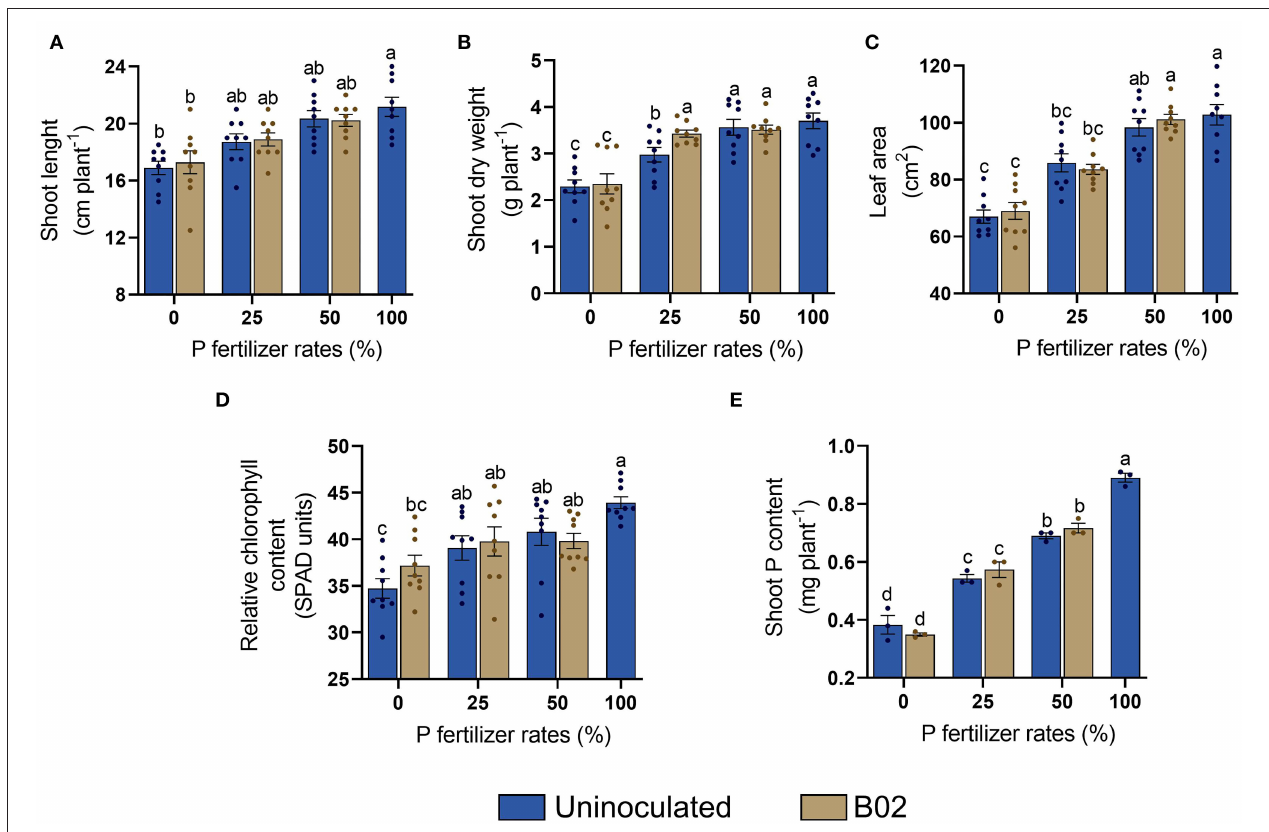
FIGURE 5 | Influence of the inoculation with Rhizobium sp. B02 on shoot length (A) , shoot dry weight (B) , leaf area (C) , relative chlorophyll content (D) , and shoot P content (E) of the yellow endosperm genotype of maize at the vegetative stage of tillering (V5). Except for shoot P content (three measurements), the means and standard errors resulted from three replicates and three independent repetitions (nine measurements). Different letters indicate significant differences according to Tukey’s test ( p <